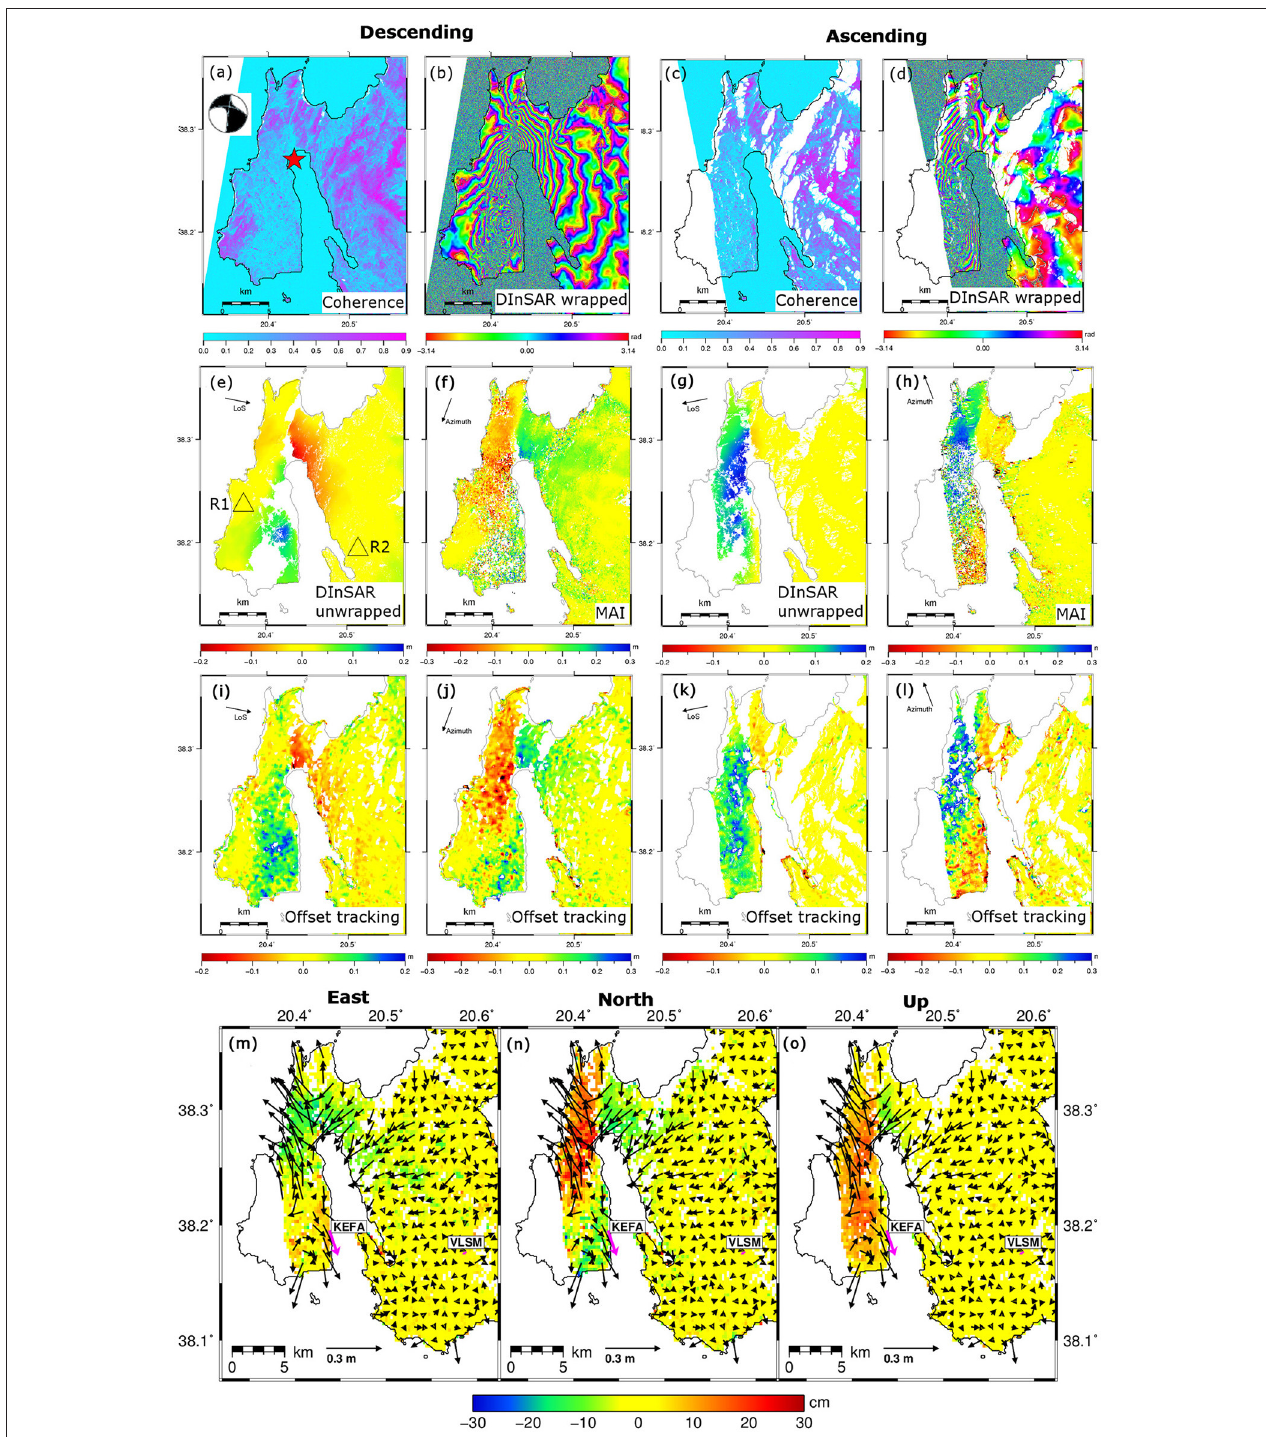
FIGURE 2 | (A,C) Interferometric coherence. (B,D) Wrapped DInSAR phase spanning the Mw 5.9 February 3rd, 2014 Cephalonia, Greece, earthquake. Each phase cycle represents 1.55cm of deformation. (E,G) DInSAR LoS deformation (positive toward the satellite). (F,H) Azimuth split-bandwidth InSAR (MAI) deformation (positive in the flight direction). (I,K) Offset-tracking LoS deformation. (J,L) Offset-tracking azimuth deformation (M–O) East, North, Up deformation. Descending image pair, panels (A,B,E,F,I,J) : COSMO-SkyMed-1/2 Stripmap, 02 February 2014 and 10 February 2014. Ascending image pair, panels (C,D,G,H,K,L) : TanDEM-X Stripmap, 28 January 2014 and 08 February 2014. Panel (A) also shows the focal mechanism at the location of the earthquake epicenter. Copyright Seismological Society of America. Adapted from Figure 3, Figures S1–S6 in Merryman Boncori et al. (2014).